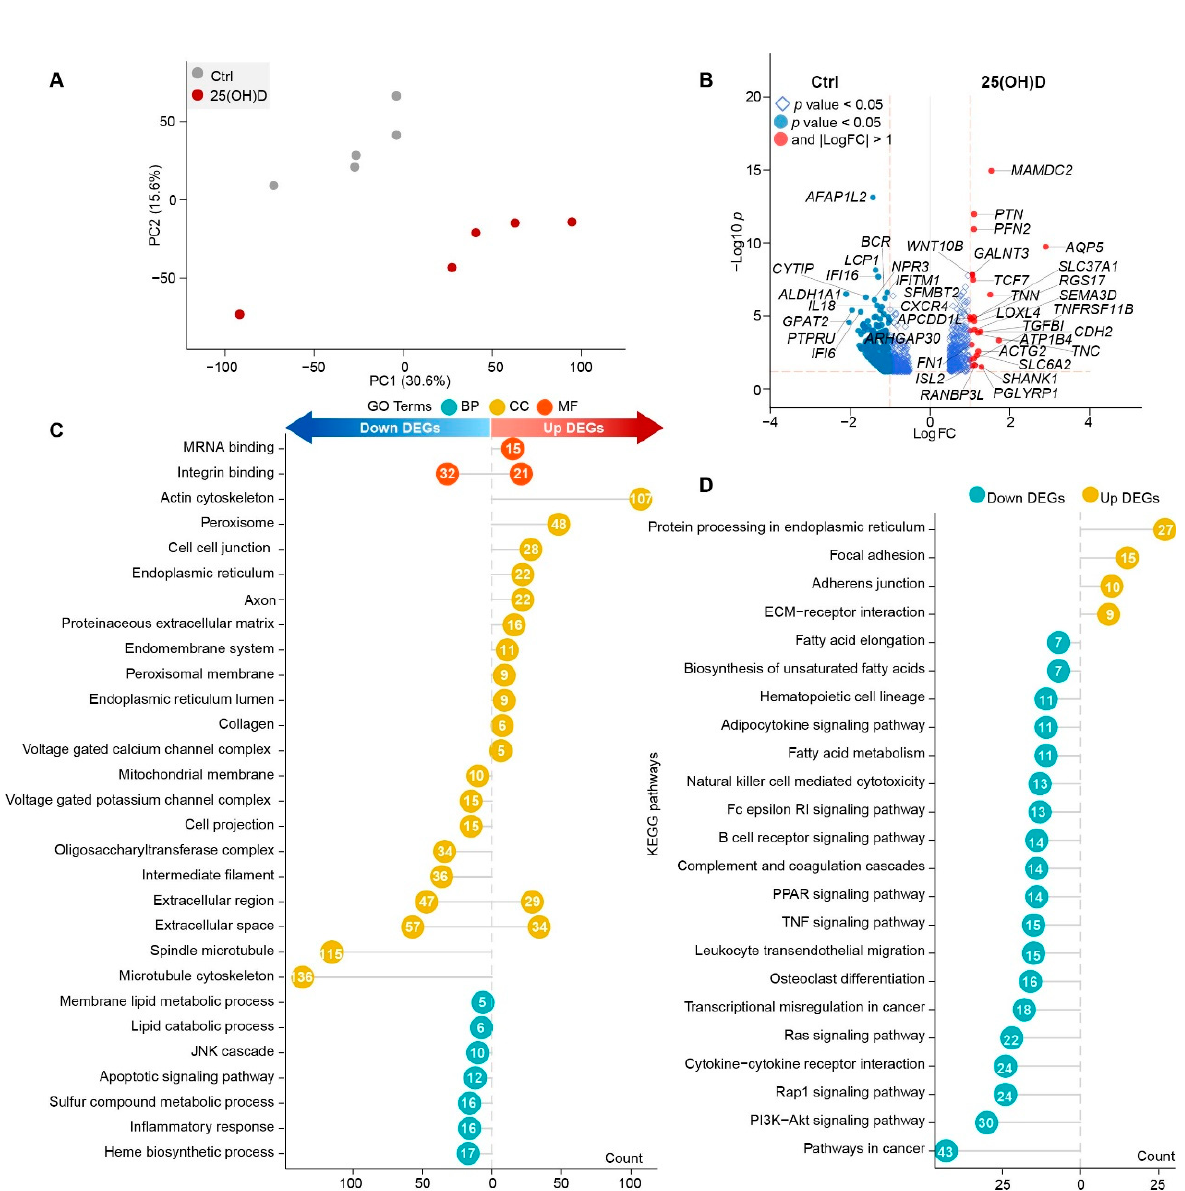
Figure 4. 25(OH)D supplementation affects the gene expression of the AGC tissue. ( A ) PCA analysis of the gene expression in the AGC tissue of sika deer between the Ctrl and 25(OH)D groups. ( B ) Volcano plots show up- and down-DEGs in the AGC tissue between two groups. Red and blue dots indicate up- and down-regulated DEGs ( p < 0.05 and |log 2 (FC)| > 1) in the 25(OH)D group compared to Ctrl group. FC = fold change. The enriched GO terms ( C ) and KEGG pathways ( D ) of the up- and down-regulated DEGs in the 25(OH)D group in comparison with the Ctrl group. Numbers in circles indicate the number of DEGs.